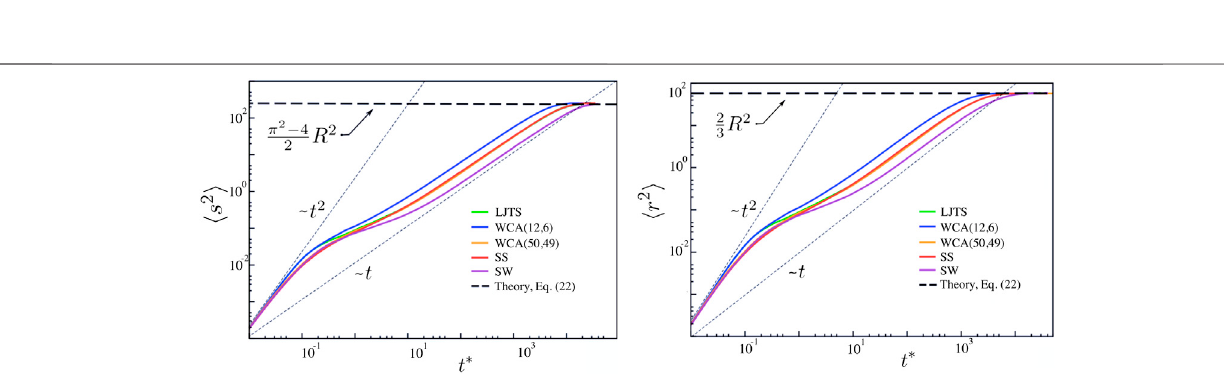
Frontiers in Physics |